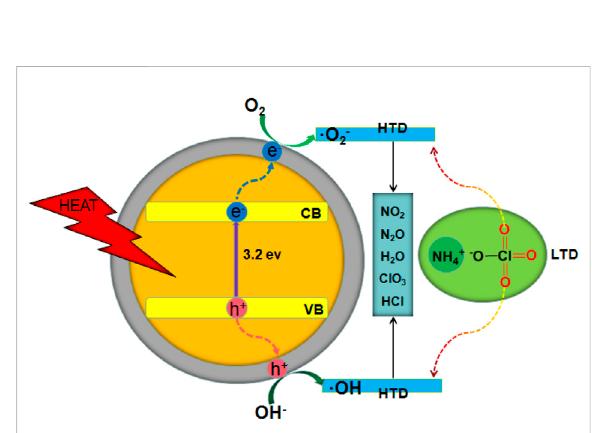
FIGURE 8 Schematic of the thermal decomposition of AP with TiO 2 NPs/h-BN as additives; CB, conduction band; VB, valence